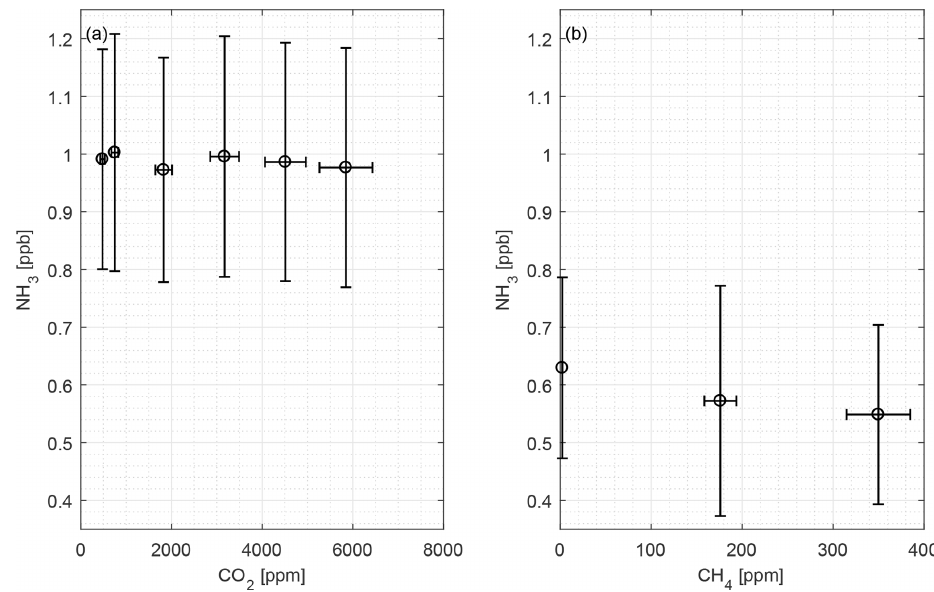
Figure 6. The CRDS signals of NH 3 in zero air response to various concentrations of (a) CO 2 (480–5848ppm) and (b) CH 4 (2.42–350ppm) under laboratory conditions. Symbols represent measured values and vertical and horizontal bars the standard deviation of the measurements.